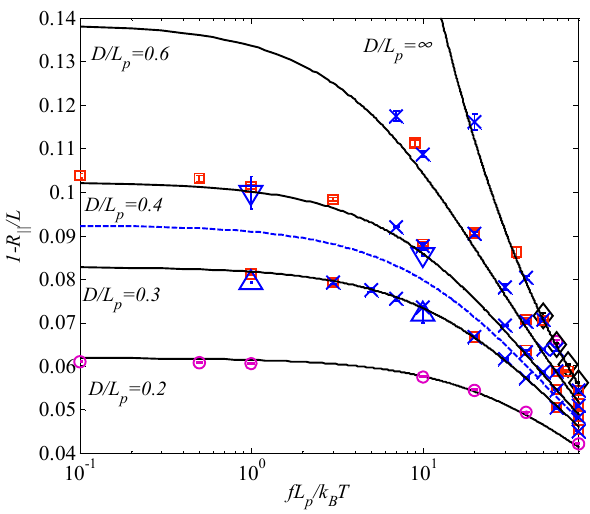
Figure 5. Comparison of Brownian dynamics simulation results and theoretical predictions on the relative average extension of the WLC confined in a tube and under stretch.